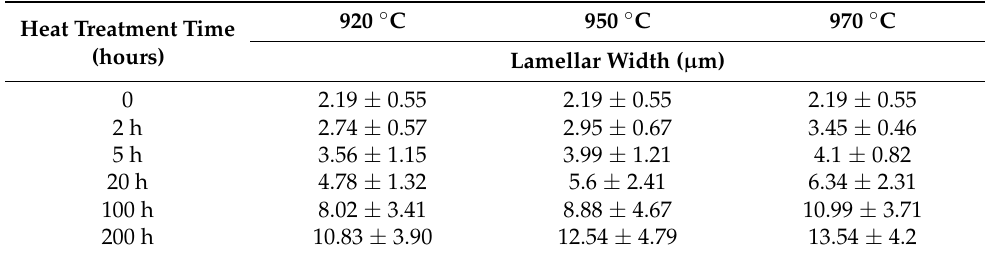
Table 6. Average lamellar width after heat treatment at 920, 950, and 970 ◦ C as a function of time.